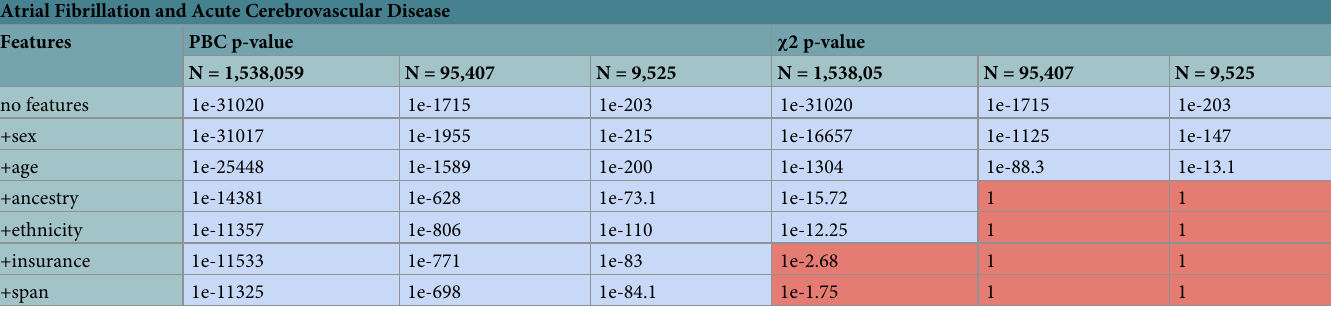
Table 1. PBC is well powered for comorbidity discovery on demographically complex datasets, unlike stratification. Atrial Fibrillation and Acute Cerebrovascular